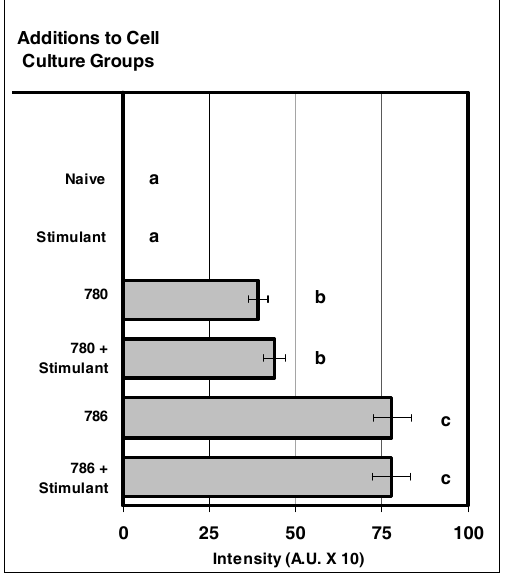
Figure 4: NIR micro-sensor dyes exhibit intracellular fluorescence after internalization by neutrophils. Neutrophil cultures were treated with either vehicle or NIR micro-sensor dyes (NIR-786 or NIR-780; 20 µg/10 6 cells) and incubated for 24 hours. After this incubation period, the cultures were stimulated with LPS for 24 hours. After the 24-hour stimulation period, intracellular fluorescence of the micro-sensor dyes was analyzed. Percent values are expressed as the mean + SEM, N = 8. Statistical significance (a), (b), and (c) were expressed as P < 0.05 in comparison to each